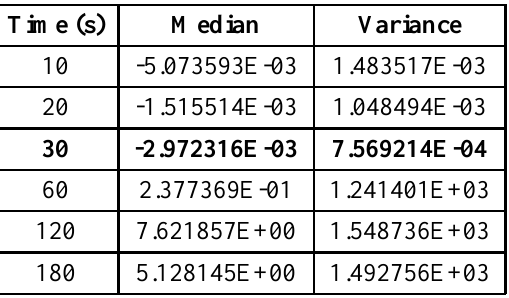
Table 5. Absolute error when varying the time